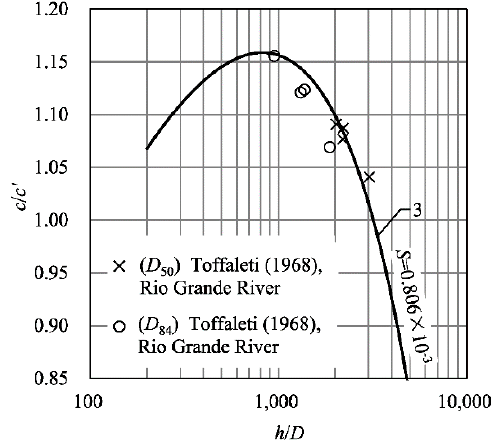
Figure 12. The relation of the resistance factor ratio c / c ′ to the relative depth h / D with different types of D .